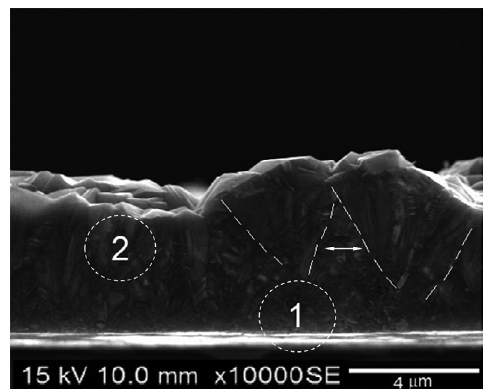
Figure 1. Diamond film thickness on Ti6Al4V sample. Region “1” shows that there is a heterogeneous interface between the film and substrate, while in “2”, it is possible to verify a columnar diamond shape.